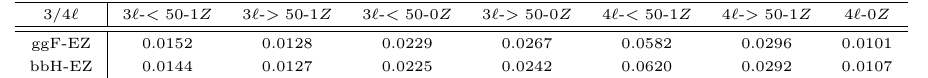
Table 4 . Efficiencies for 3 / 4 ‘ searches. 7 50 is for E miss